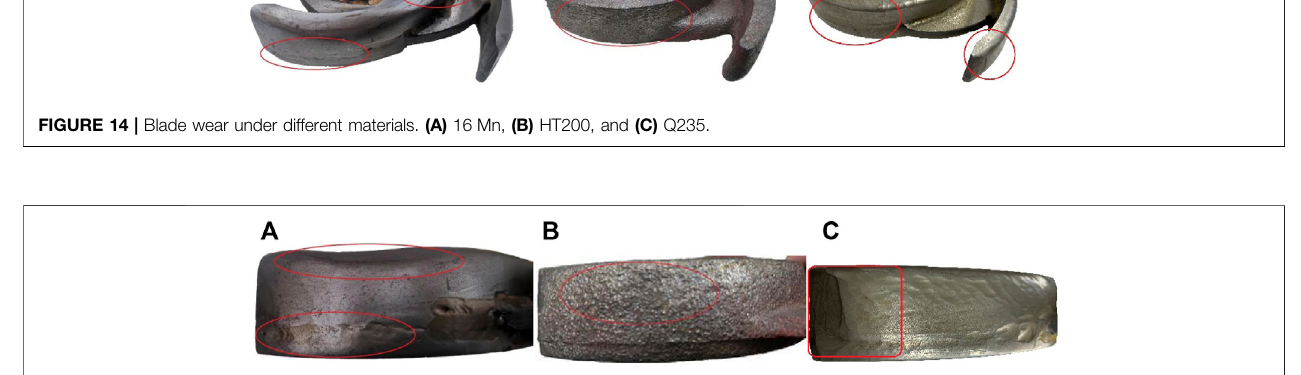
FIGURE 15 | Pressure surface wear under different materials. (A) 16 Mn, (B) HT200, and (C) Q235.